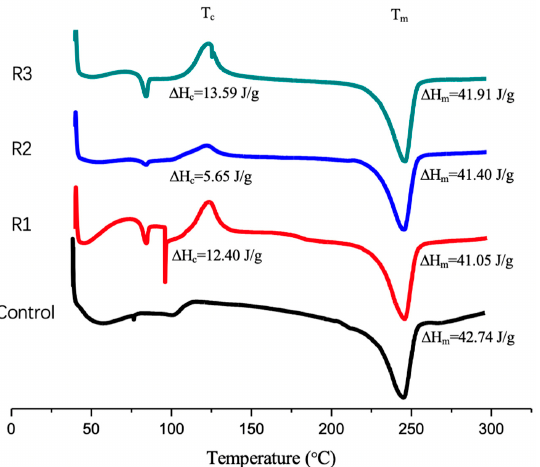
Figure 5. DSC diagrams of PET samples treated with Trx- Is PETase (R1, R2, and R3 denote three independent reactions) and the control without the enzyme. Notice that all enzymatic reactions pro- duced a cold crystallization peak (T c ) at 122 °C, while the control did not.